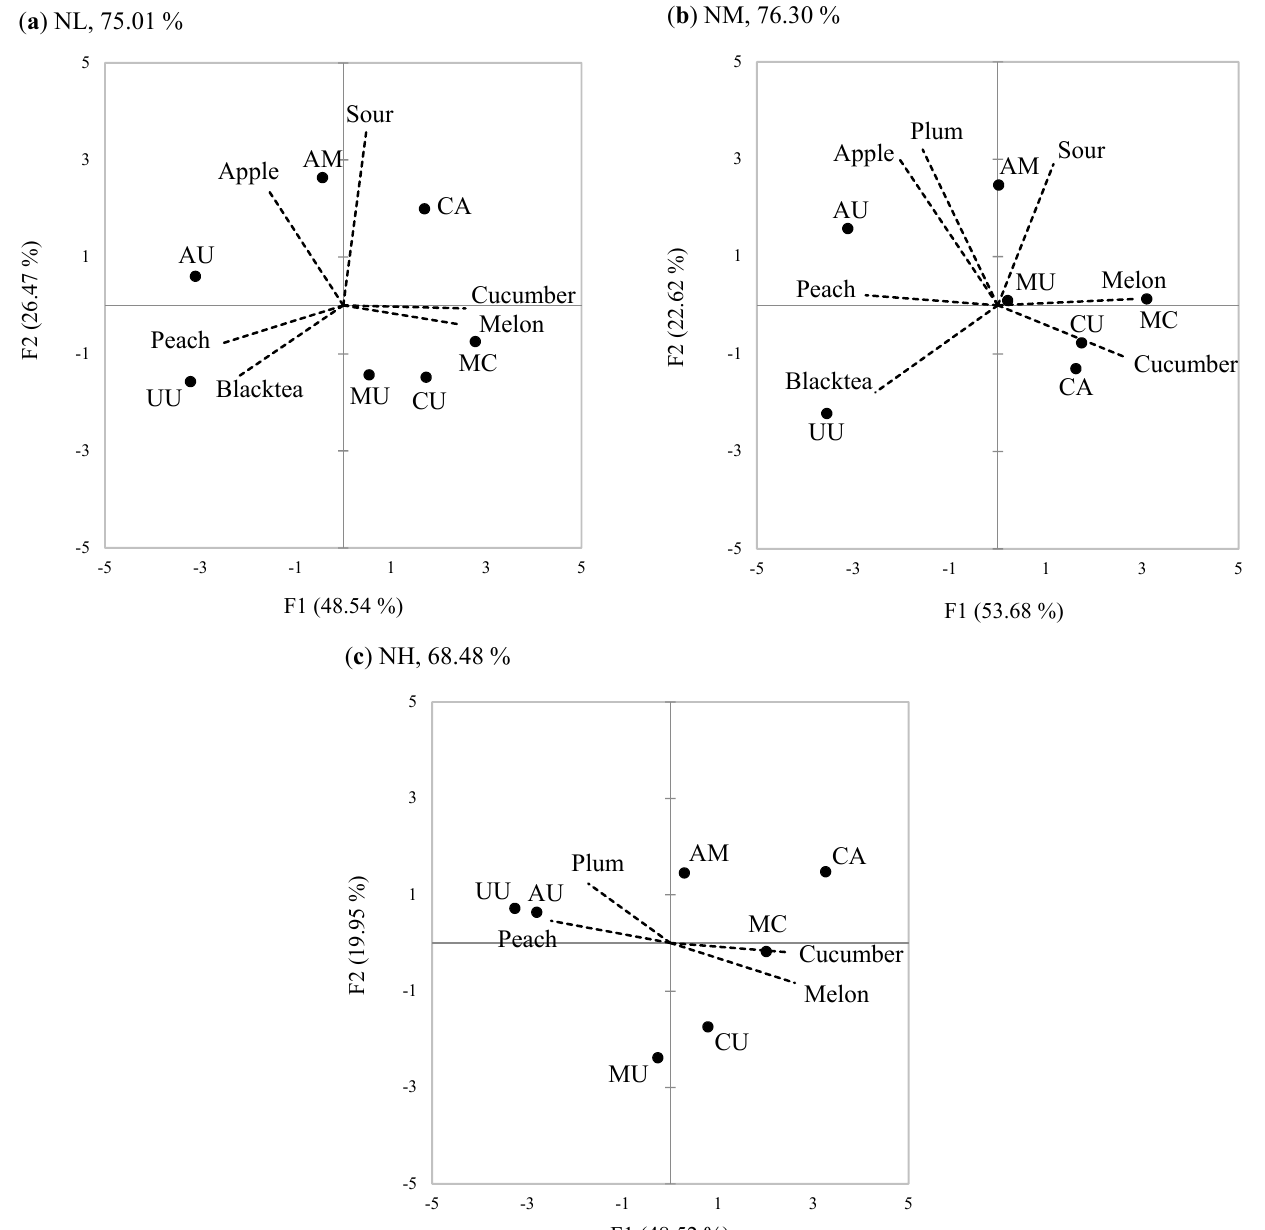
Figure 5. PCA biplot of the samples (filled circles) and the sensory attributes (dotted line) for the first two PC dimensions: ( a ) lower food neophobia (NL); ( b ) moderate food neophobia (NM); ( c ) high food neophobia (NH). See Table 1 for sample codes. Only the attributes showing significant differences among the samples ( p < 0.05) are presented.